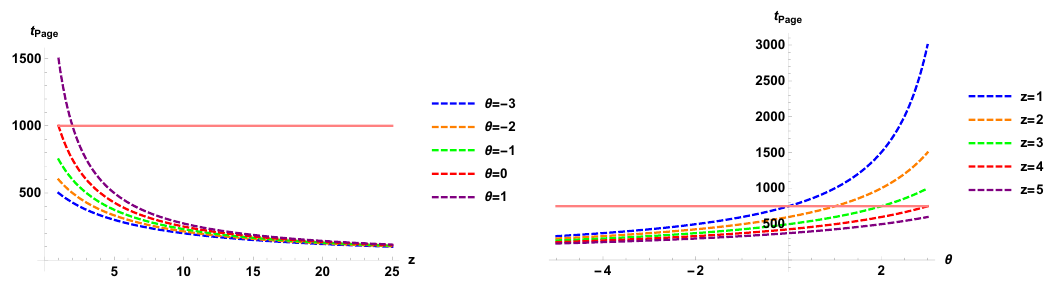
Figure 3 . Page time when the matter is described by a CFT d +2 or a holographic HV QFT d +2 with θ m = 0 as a function of ( Left ) z for d = 2 and different values of θ . ( Right ) θ for d = 3 and different values of z . The solid pink line indicates t is a decreasing and increasing function of z and θ , respectively. Here we set c = A = V